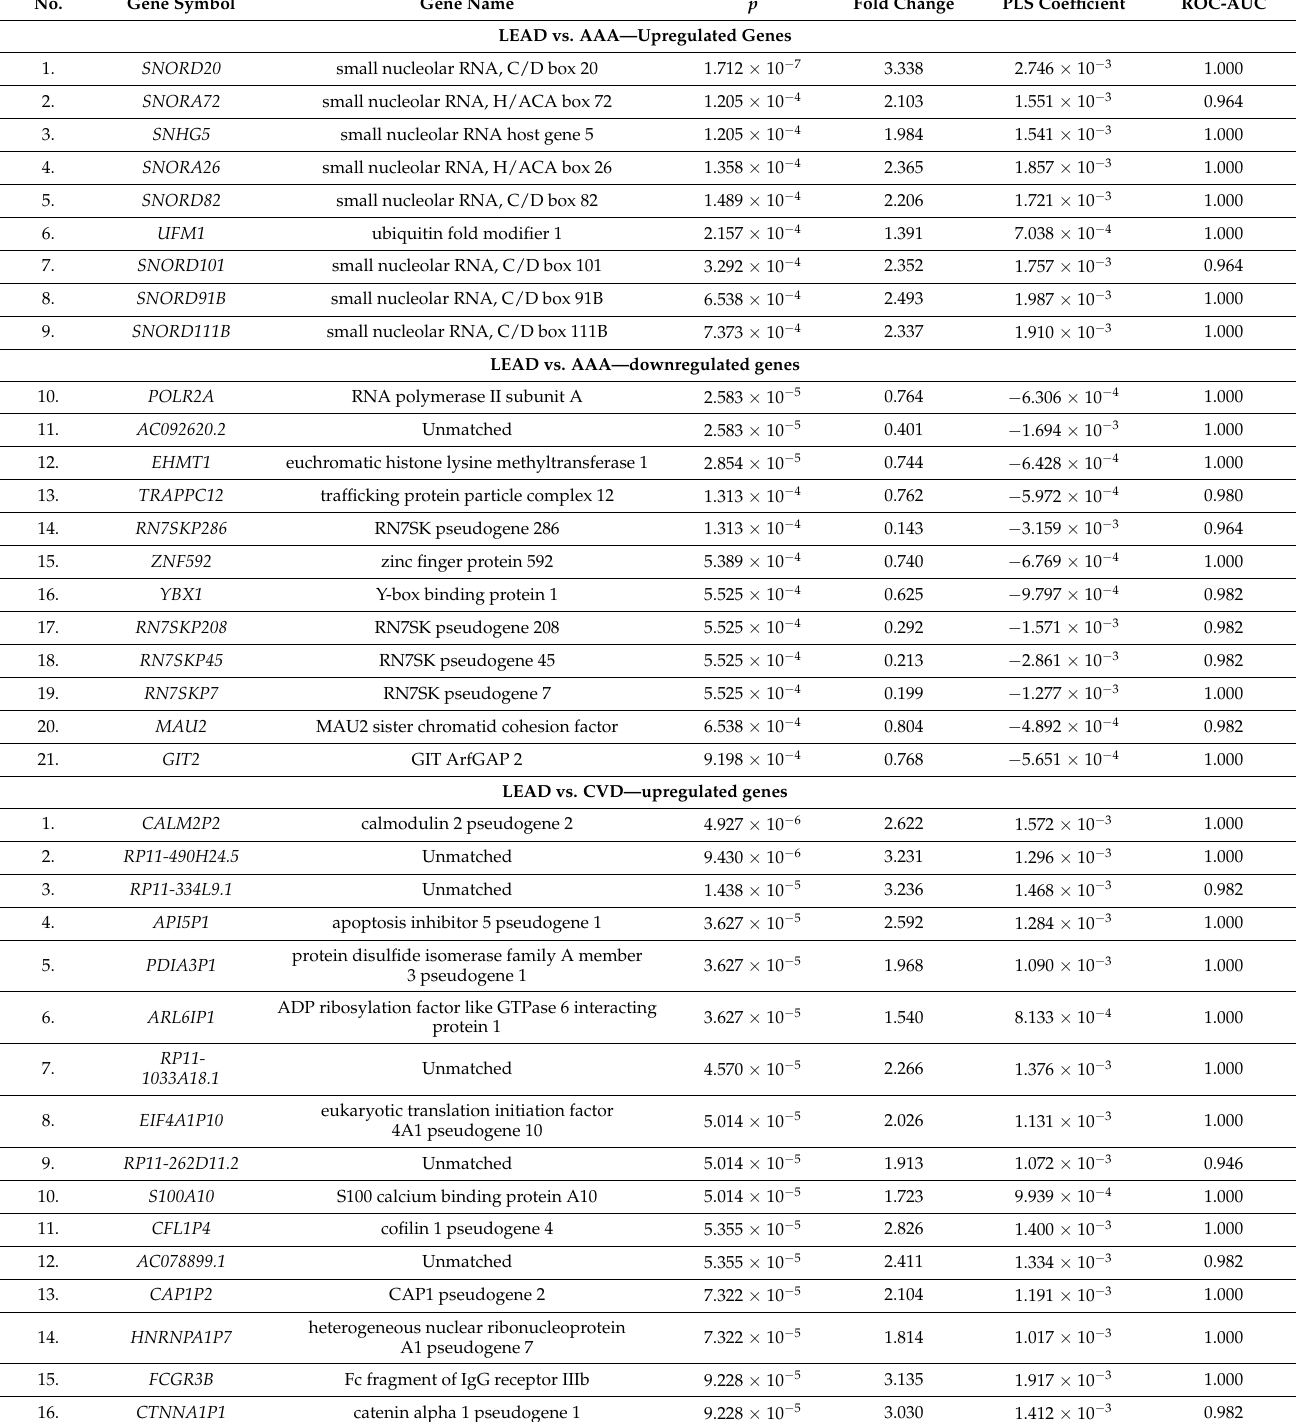
Table 2. Differential expression parameters of 21, 58 and 10 genes identified as unique for LEAD vs. AAA, LEAD vs. CVD and AAA vs. CVD comparisons, respectively. The table presents p (FDR with Benjamini–Hochberg correction) and fold change values received from DESeq2 analysis, PLS coefficients received from UVE-PLS analysis and areas under ROC curves (ROC-AUC) received from ROC analysis. Genes were divided into upregulated and downregulated groups within each comparison and ordered according to increasing p value. Gene symbols without assigned gene names by HUGO Gene Nomenclature Committee Multi-symbol checker (https://www.genenames.org/tools/multi-symbol-checker/, accessed on 20 January 2021) were named as